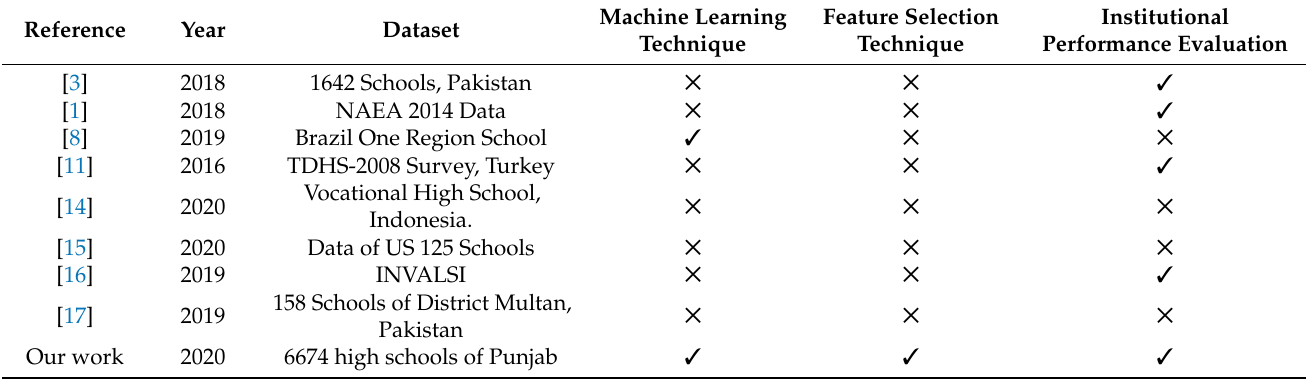
Table 1. Overview of existing